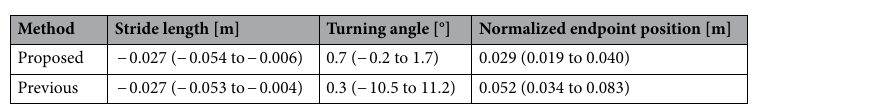
Table 5. Comparison results of the estimation error between the proposed method and the previous method in the stride length the turning angle, and the normalized endpoint position, respectively.